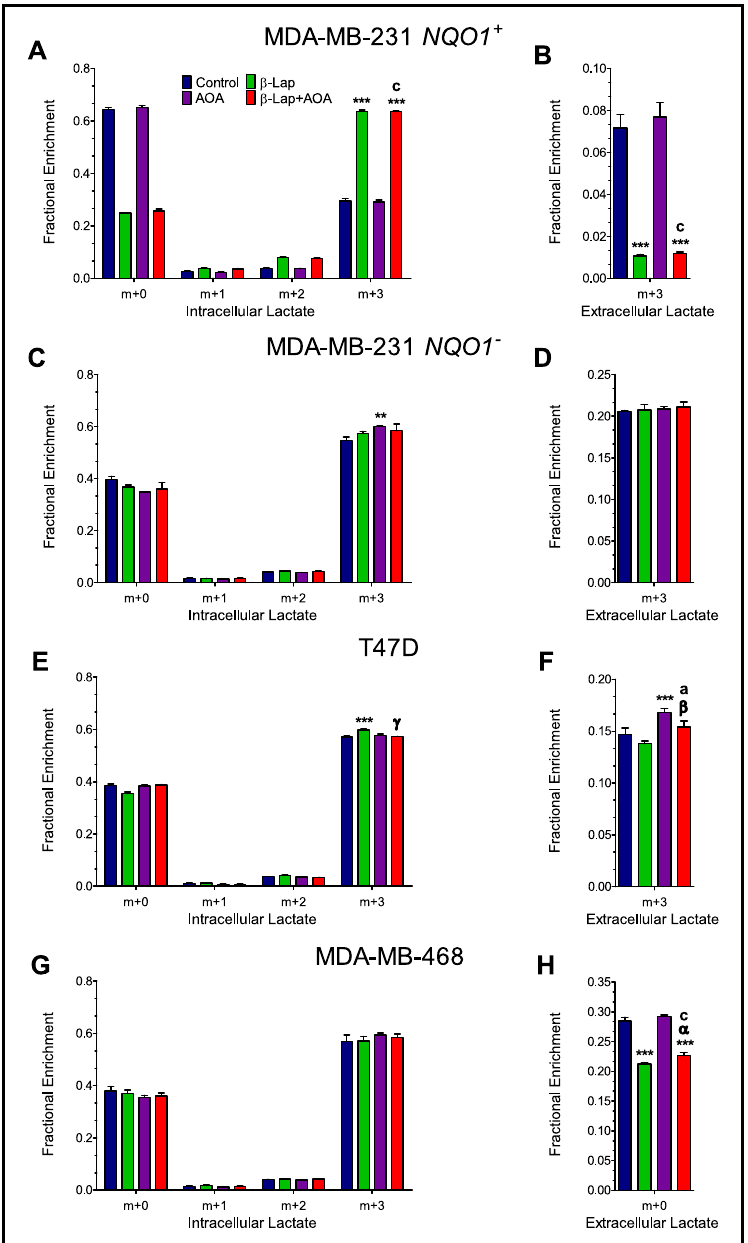
Figure 2. Evaluating glycolytic output by analyzing the intracellular and extracellular isotopologues of lactate in MDA-MB-231 NQO1 + (Panels ( A , B )) and MDA-MB-231 NQO1 − cells (Panels ( C , D )). β -lap action drives glycolytic slowdown in NQO1 + cells as evidenced by significantly lower lactate secretion supported by higher intracellular enrichment of m+3 lactate in β -lap and combined treat- ment compared to control, and significantly lower extracellular enrichment of m+3 lactate in the same groups. Conversely, treatment was inconsequential across groups in NQO1 − cells. Intracellular and extracellular lactate isotopologue distribution in T47D are shown in (Panels ( E , F )) and MDA- MB-468 in (Panels ( G , H )) breast cancer cells. (Note: n = 3, biological replicate data are represented as mean ± SEM. Statistical significance was determined by ANOVA and student’s t -test post hoc